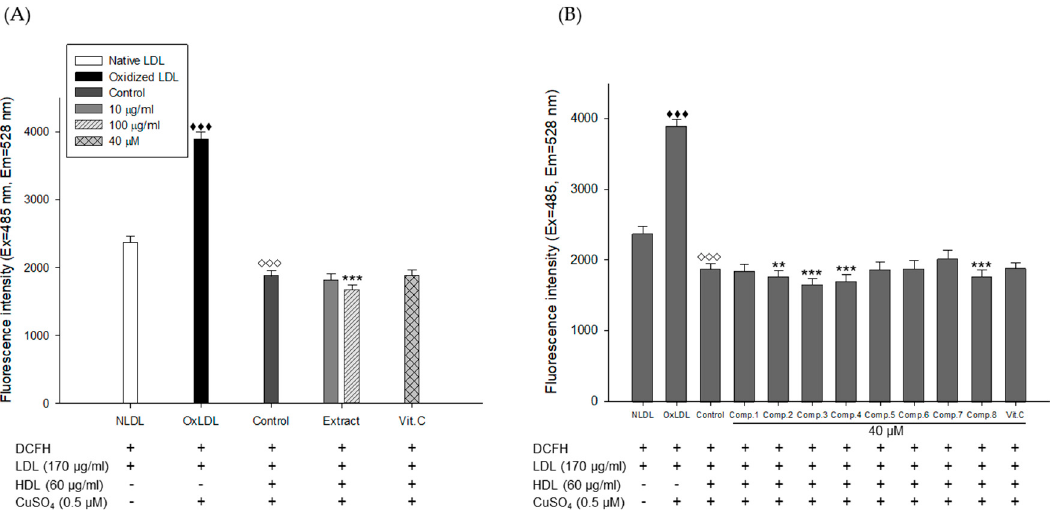
Figure 8. HDL treated with E. koreanum extract or its eight flavonoids inhibited ROS production from Cu 2 + -induced LDL oxidation. ( A ) Inhibitory e ff ect of E. koreanum extract treated-HDL on LDL oxidation. ( B ) Inhibitory e ff ect of eight flavonoids treated-HDL on LDL oxidation. The formation